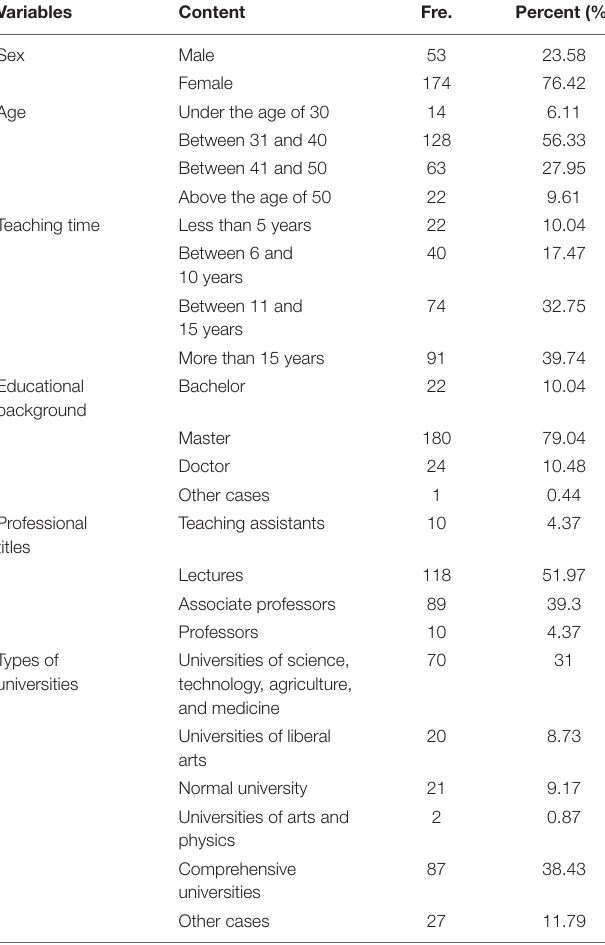
TABLE 3 | The integrated initial CETPE scale (translated from the Chinese version). Items